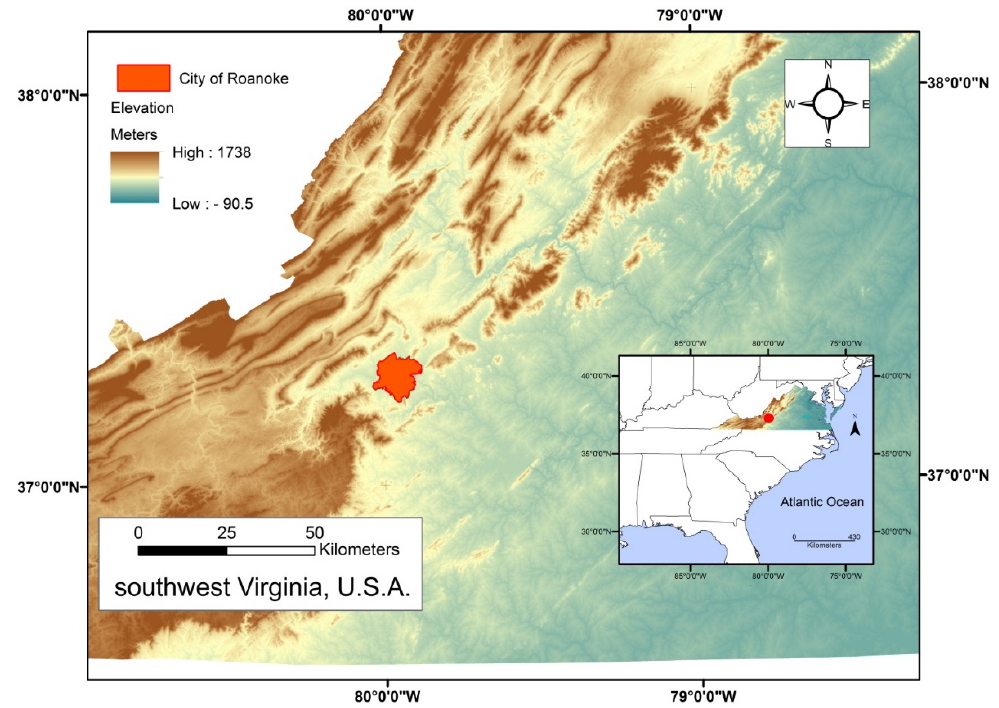
Figure 1. City of Roanoke, Virginia, USA Reference